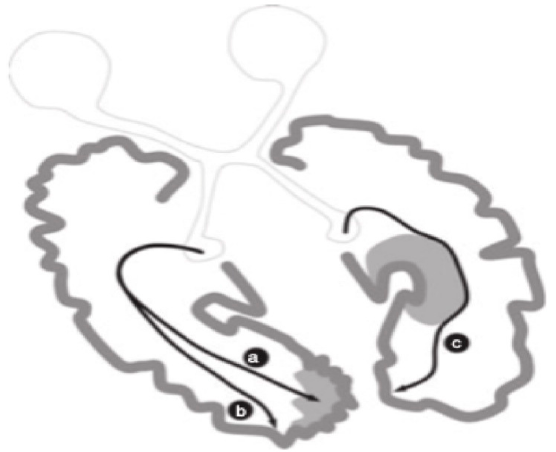
Figure 3. Potential mechanisms of neuroplasticity-based functional reorganization supporting normal visual function in congenitally brain-damaged individuals. ( a ) Represents damage to the PVC with functioning tissue existing within the lesion ( b ) aa reorganization occurring in regions external to the accepted boundaries of the PVC; ( c ) the geniculostriatal pathway bypassing the lesion and projecting to the calcarine cortex (after Guzzetta et al. [47] with permission).